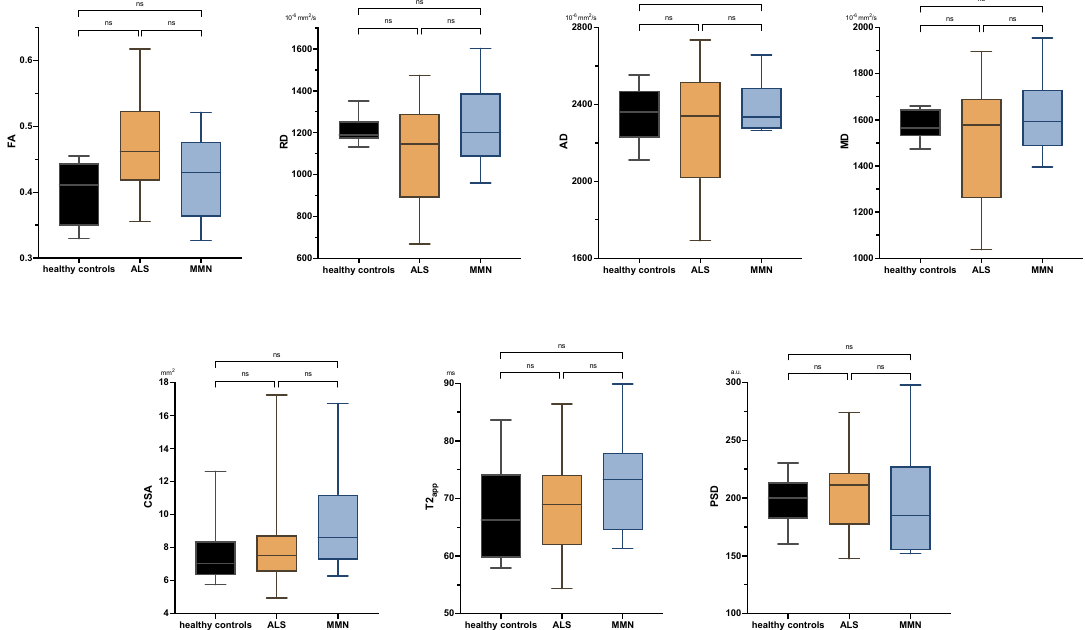
Figure A1. Boxplots of DTI parameters (upper row), cross-sectional area (CSA), and T2-relaxometry metrics (lower row) measured in the tibial nerve at the proximal calf. One-way analysis of variance with Holm–Sidak(cid:31)s correction, statistical signi fi cance was set at p ≤ 0.05. The plots illustrate the 25–75th percentiles (boxes) and minimum-to-maximum values (whiskers). Ns, not signi fi cant. Table A1. Individual clinical/neurological characteristics of patients.